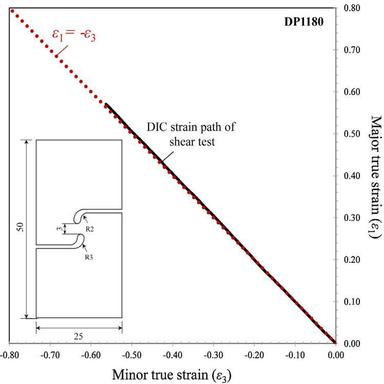
6. Shear specimen geometry of Peirs et al (all dimensions are in millimetres), and measured strain path of a representative shear test on DP1180.